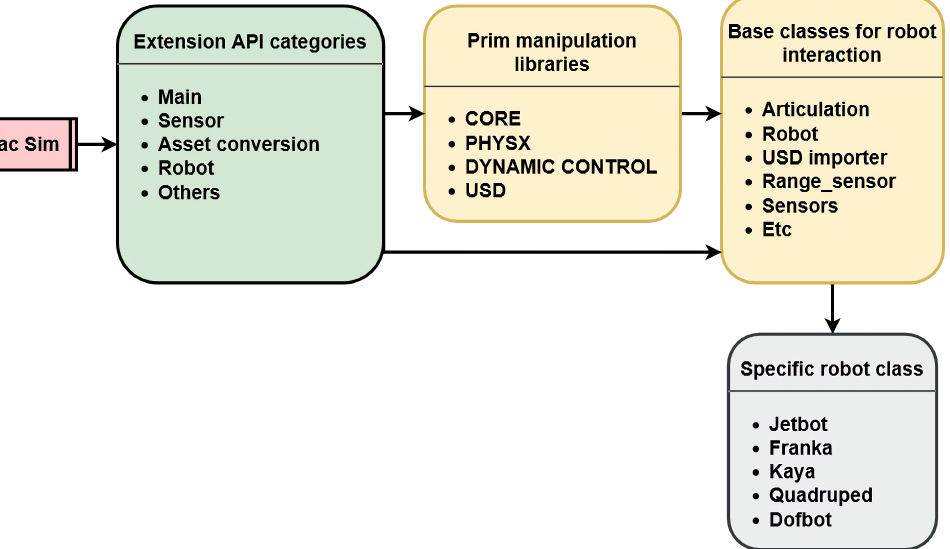
Figure 1. The internal process of Isaac Sim to control a specific